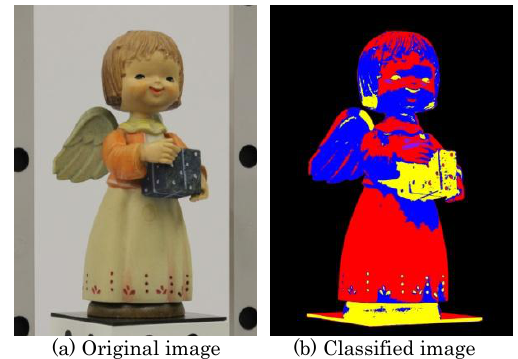
Figure 5. Image processed using an Otsu method. Figure 6. TIN model and orthophoto